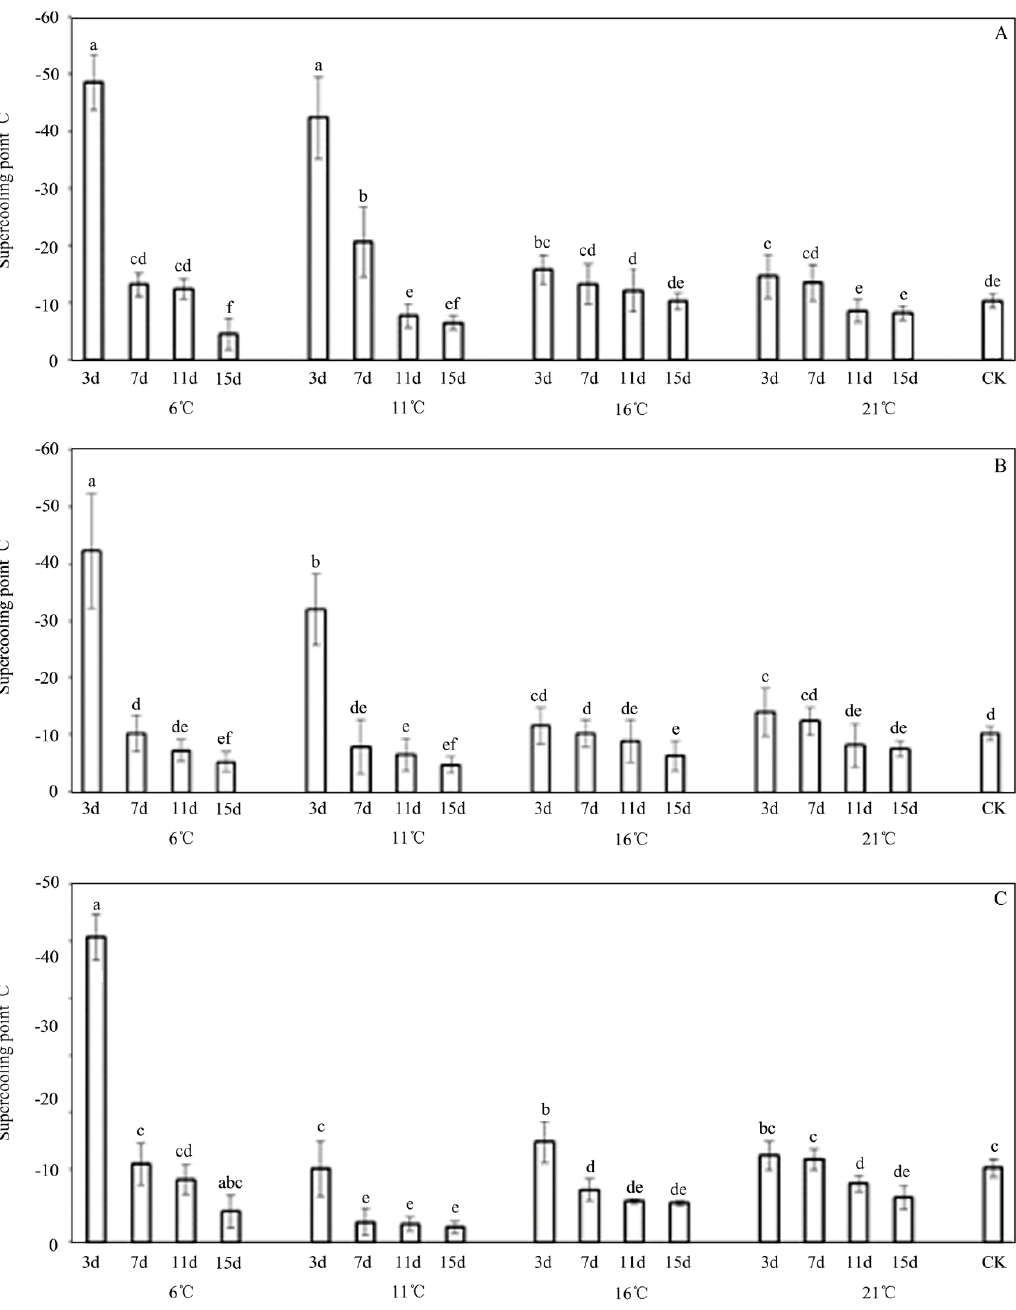
Figure 3. Supercooling point of E. extimalis treated with Pseudomonas syringae , 1.3200. ( A ) 0.1 OD; ( B ) 0.2 OD; ( C ) 0.3 OD. Results are shown as the mean ± SD. Letters on the error bars indicate significant differences analyzed by the one-way analysis of variance (ANOVA) with Tukey’s test ( p ＜ 0.05).